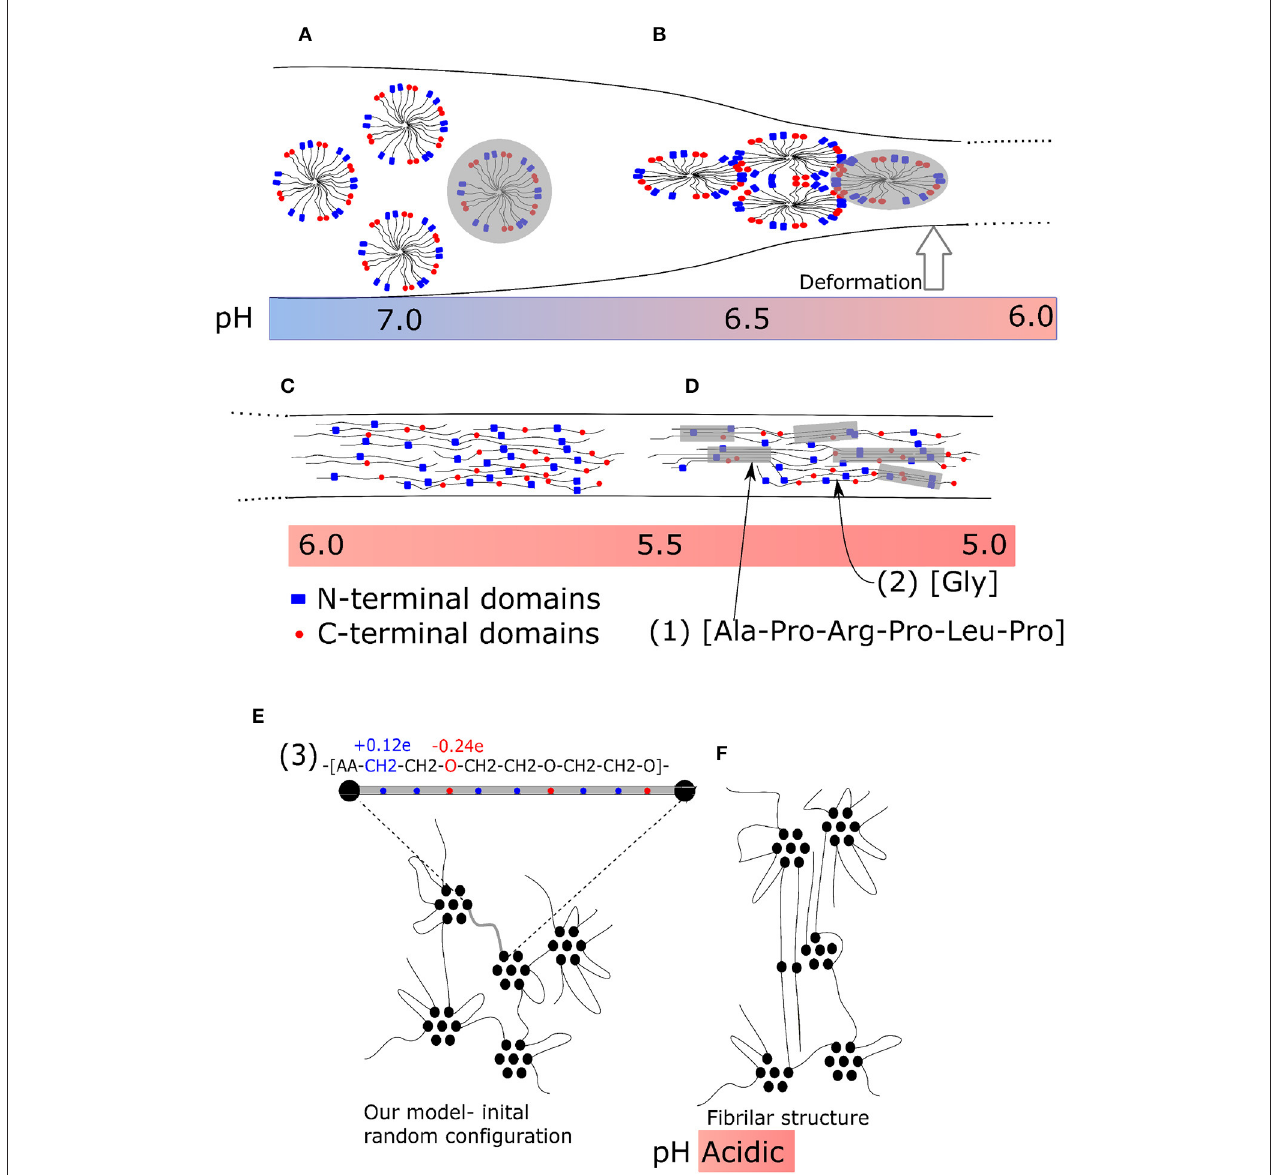
FIGURE 1 | Fiber formation mechanism of spider silk during tensile deformation. (A) Micellar network: not deformed; (B) Liquid crystalline phase: moderate deformation; (C) Nanocrystalline fibrillar structure: strong deformation. (A–C) Enlarged parts of structures. (1) Typical secondary structure (amino acid sequence) of nanocrystalline chain, (2) typical flexible connecting chain rich in glycine, and (3) a repeating unit of our model. (D) Final structure of spider silk with β -sheets. (E) Micellar structure before deformation; (F) model nano-fibrillar structure after